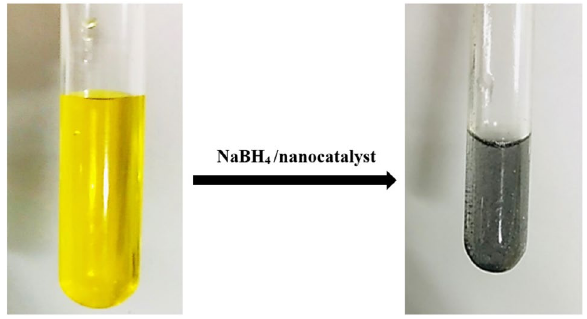
Figure 11. The colour transformation of ortho-nitroaniline after adding the